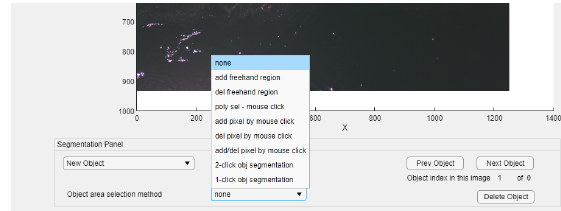
Figure 9. Segmentation panel: object area selection tools.